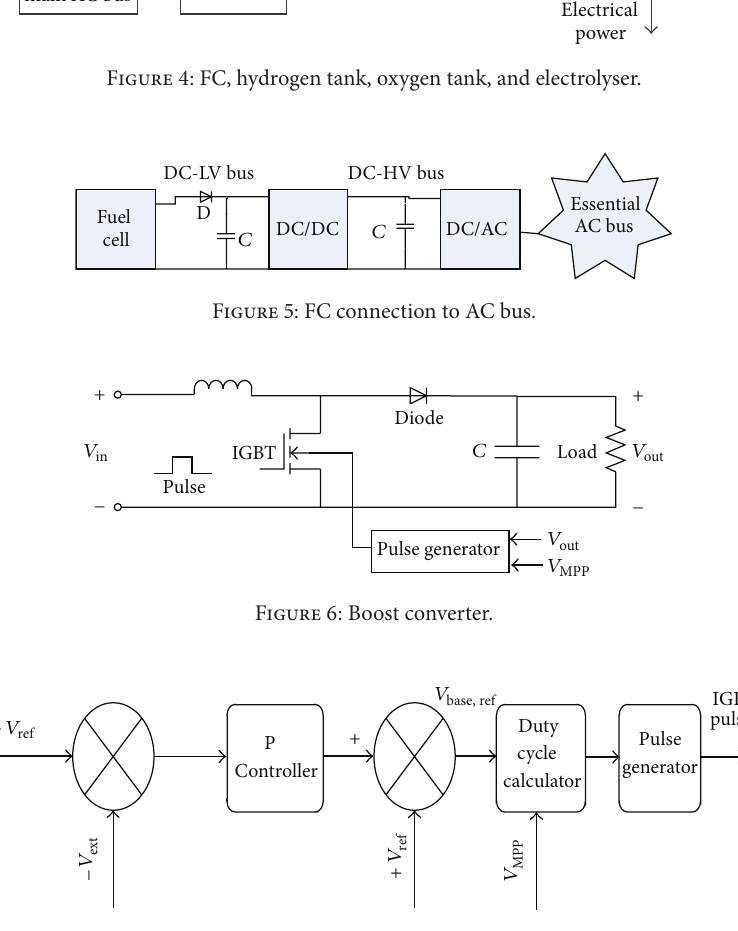
Figure 7: Generating of pulses for switches and their control blocks.